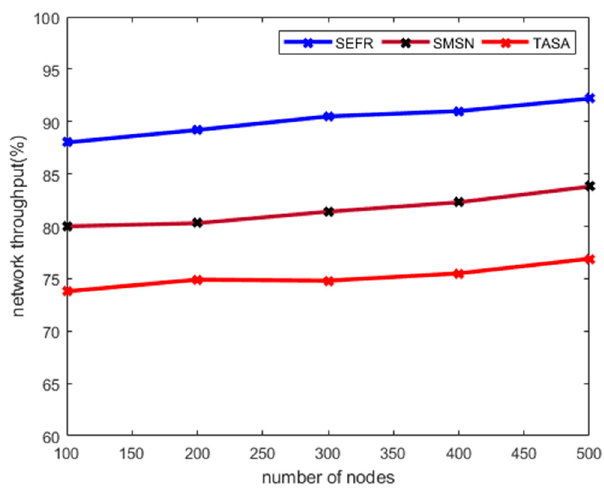
Figure 5. Network throughput with varying number of nodes.